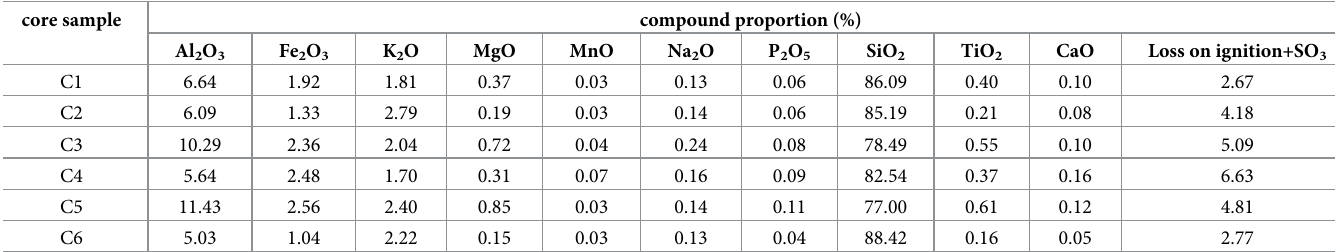
Table 2. Percentages of elemental compounds of the core samples. core